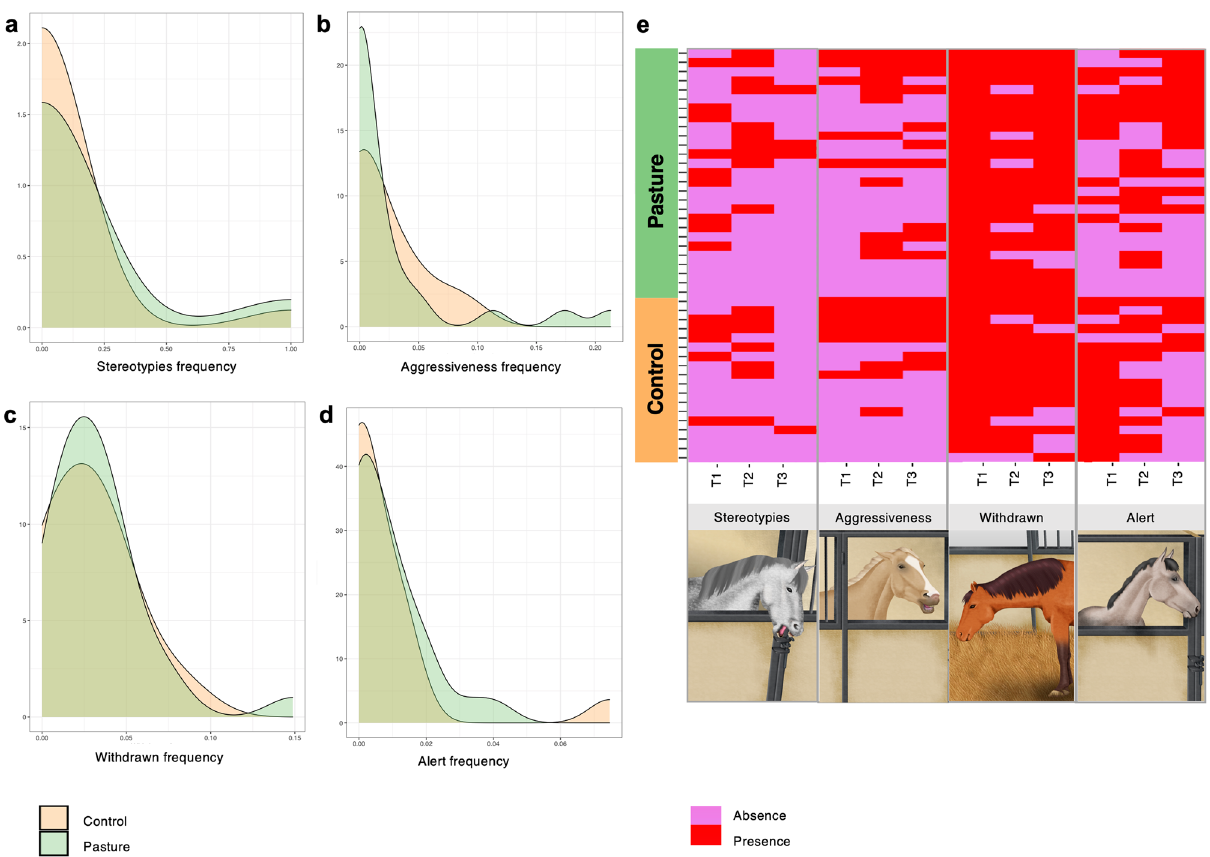
Figure 2. Frequency of behaviors related to welfare impairment in each of the individuals at baseline (from T1 to T3). ( a ) Density plot showing the frequency of scans of stereotypies in pasture and control groups; ( b ) density plot showing the frequency of scans of aggressiveness behavior towards humans in pasture and control groups; ( c ) density plot showing the frequency of scans of unresponsiveness to the environment in pasture and control groups; and ( d ) density plot showing the frequency of scans of hypervigilance or alert behavior in pasture and control groups; ( e ) matrix showing the presence or absence of the behavioral indicator detected in our cohort before the pasture release (from T1 to T3). Each entry in the matrix indicates the presence or absence of each behavioral indicator in each individual and time point. Individuals are grouped by treatment (pasture in green and control in orange). The drawings corresponding to the stereotypy and withdrawn behaviors have been obtained from Mach et al. 8 and used according to terms of a Creative Commons Attribution 4.0. License: http://creat iveco mmons .org/licen ses/by/4.0/. No changes were made. Written permission for publication of the drawings corresponding to aggressiveness and alert behaviors in the figure has obtained. All plots were produced in R software https ://www.r-proje ct.org, using the version Table S3). The risk of injuries was not associated with the group (trend test χ 2 = 3.375, p = 0.066) and thus, horses kept alone in boxes presented the same level of injuries than horses kept in pasture with conspecifics.